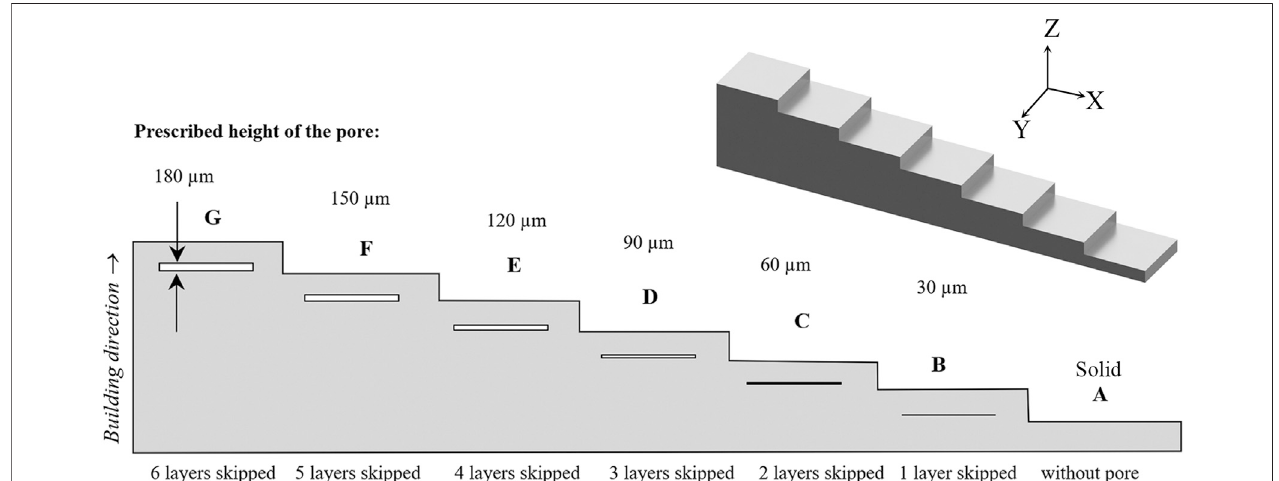
FIGURE1| Test sample,solid part (A) and parts with prescribed internal cavities of30 – 180 µm (1 – 6 powderlayersskipped) (B – G) ,axis Z isthebuildingdirection, XY is the scanning plane (top image) .